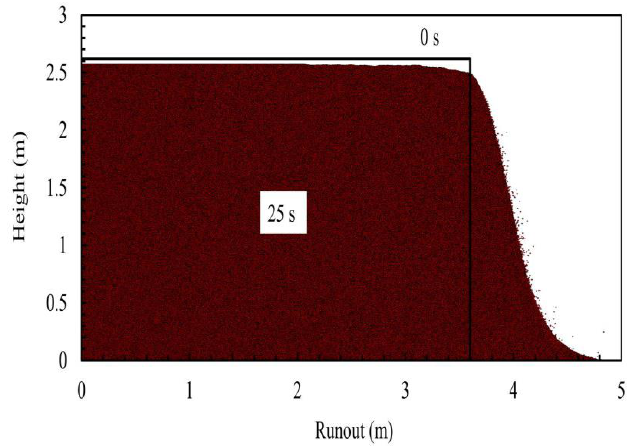
Figure 16. Runout profiles of sand pile with 1,280,000 particles.